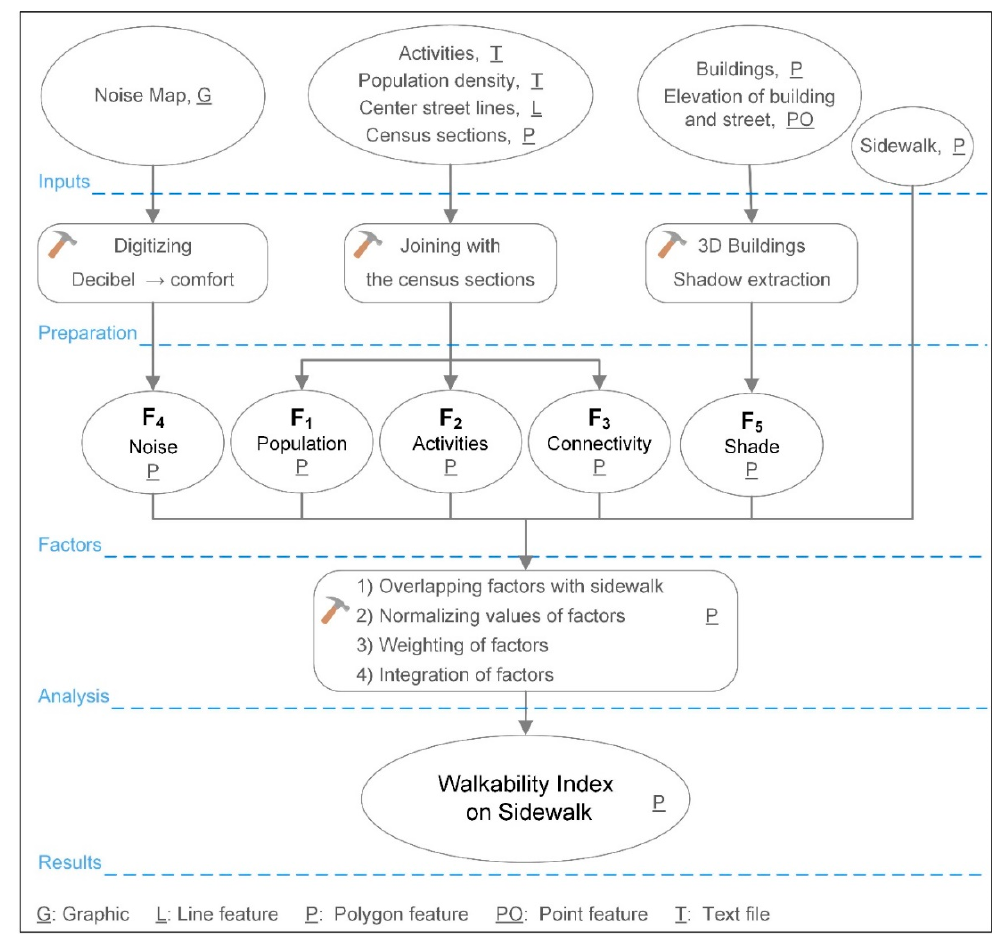
Figure 1. Cartographic model. Input data, technical steps, and results of the WI calculation.